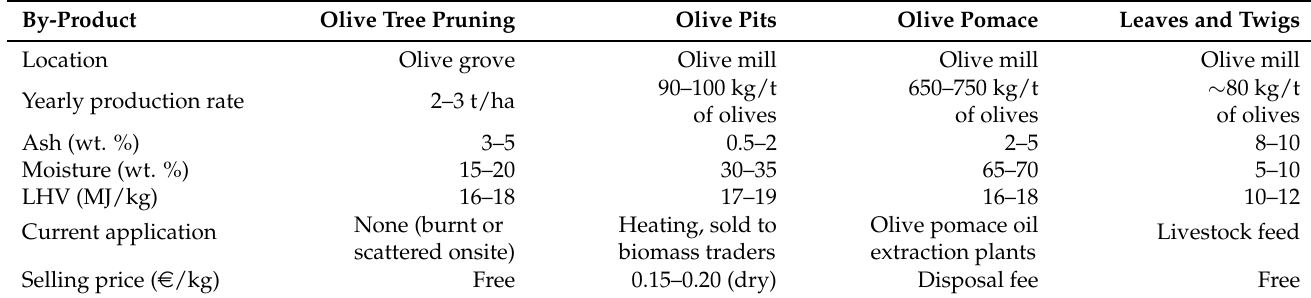
Table 1. Main properties of olive oil industry by-products (two-phase extraction